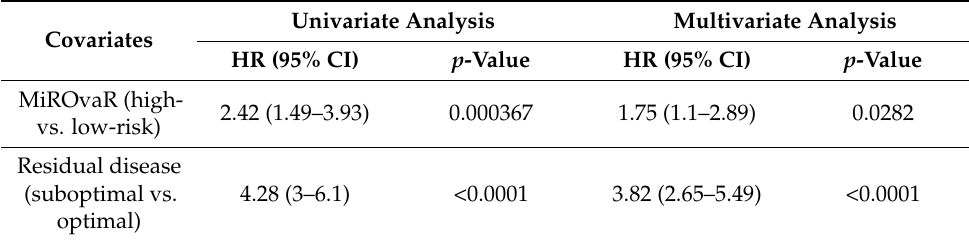
Table 2. Cox proportional hazard regression